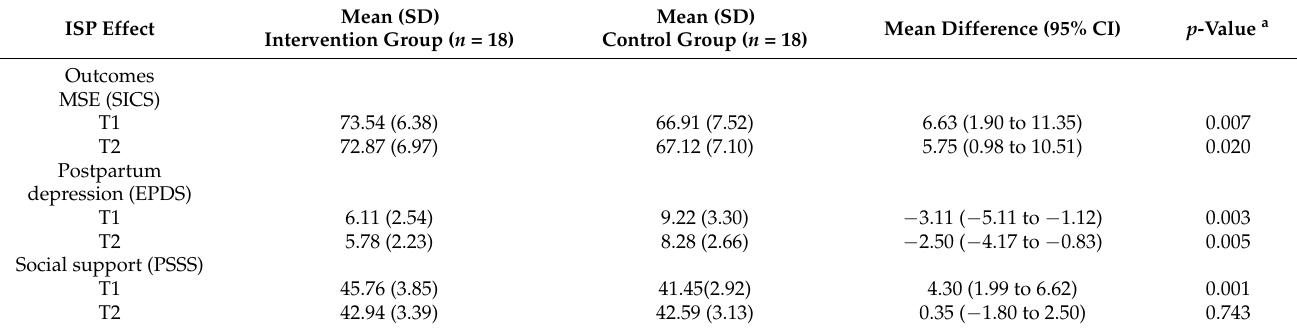
In both two groups, the MSE score of participants increased from T0 to T1, T0 to T2 ( p < 0.01); and the increase was significantly higher for the intervention group women than for the control group women. There was no significant difference of EPDS score in the intervention group with the passage of time; however, there was the significant increased EPDS score in control group from T0 to T1 (mean difference = 3.889, p < 0.001), T0 to T2 (mean difference = 2.944, p < 0.001). The social support score in the intervention group had a significant increase from T0 to T1 (mean difference = 4.298, p < 0.001), and T0 to T2 (mean difference = 1.488, p = 0.001). By comparison, no such increase in social support score was found in control group as time went on. Figure 2 showed a graphical representation of the mean score change in parenting outcomes. Table 3. Effect of the ISP on outcomes at immediately after the intervention (T1), and three months after the intervention (T2). Mean (SD) Mean (SD) ISP Effect Mean Difference (95% CI) p -Value a Intervention Group ( n = 18) Control Group ( n = 18) Outcomes MSE (SICS)